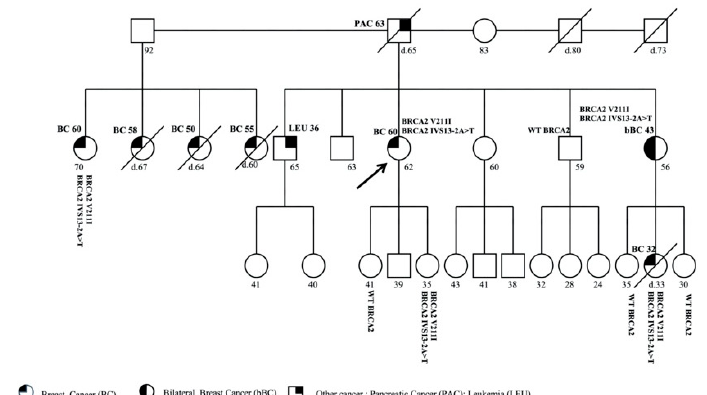
Figure 5. Pedigree of family 5 carrying the DM in BRCA2 c.631G > A (p.Val211Ile) and c.7008-2A > T (IVS13-2A > T). The ages at diagnosis are indicated in brackets.